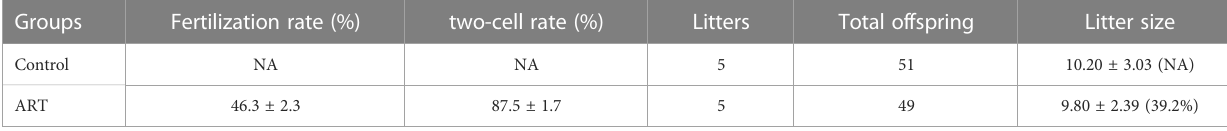
TABLE 1 Effects of ART on preimplantation embryo development and birth of offspring mice.